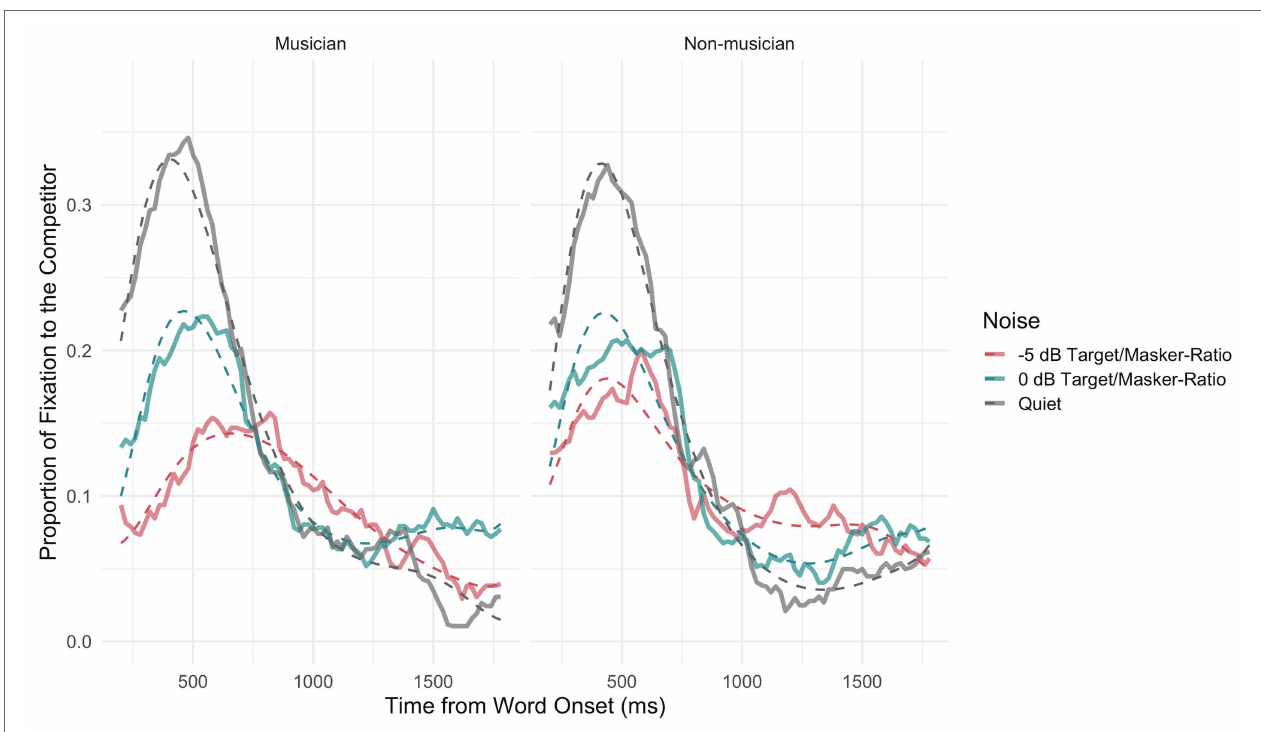
FIGURE 4 | Probability of gaze fixations to the competitor averaged across participants and items shown for musicians (left panel) and non-musicians (right panel) for the three conditions (speech-in-quiet: gray, 0 dB TMR: turquoise, and − 5 dB TMR: red) as observed in the data (solid lines) and predicted by the model (dashed